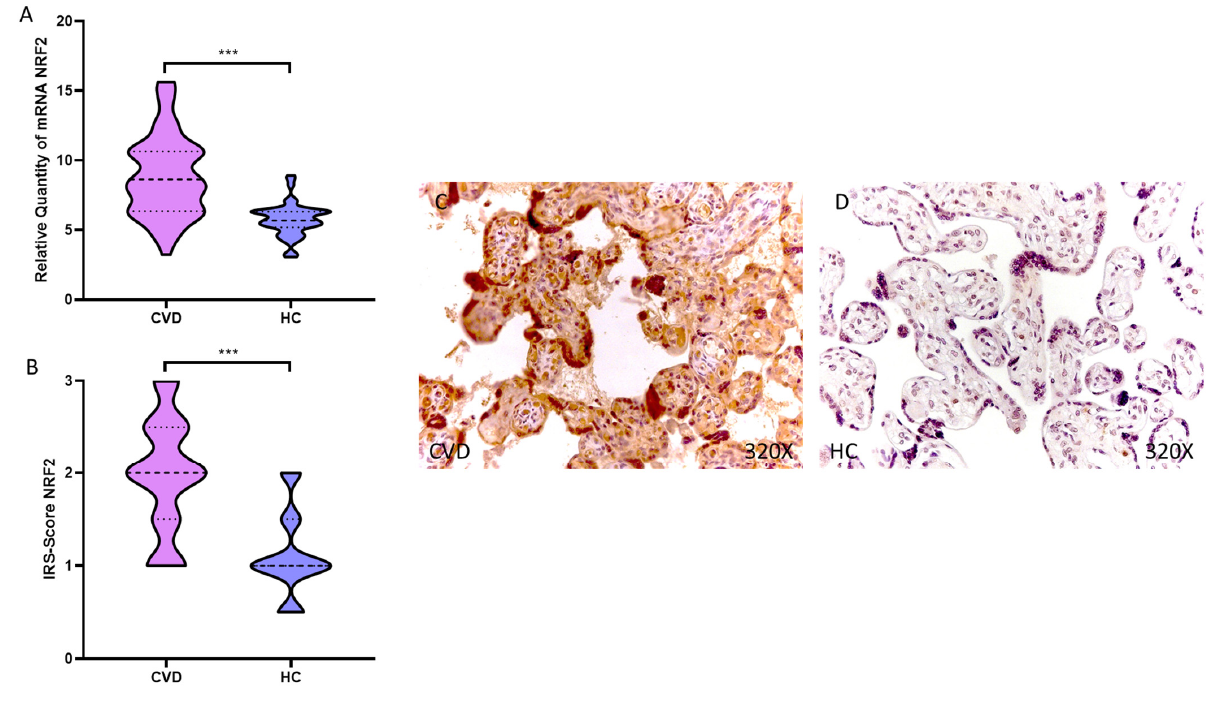
Figure 1. ( A ). NRF2 mRNA expression in the CVD patients (chronic venous disease) and HC group (Healthy controls). ( B ). IRS-Scores for NRF2 in the placenta villi of the CVD group and the HV group. ( C , D ). Images showing the immunostaining for NRF2 in the placenta villi of the CVD group and the HV group. p < 0.001 (***).